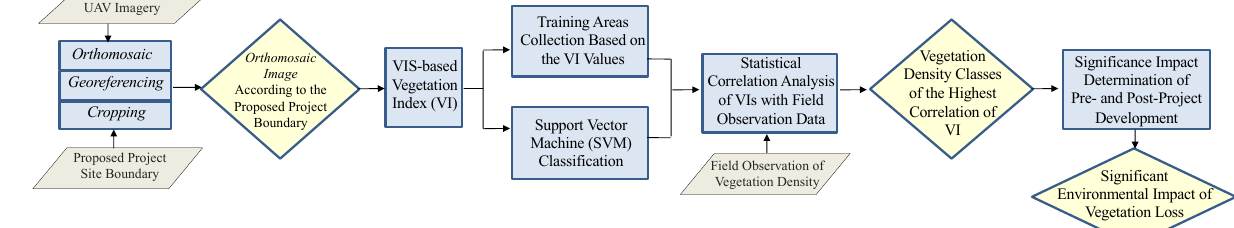
Figure 1 . Flowchart of the research and data